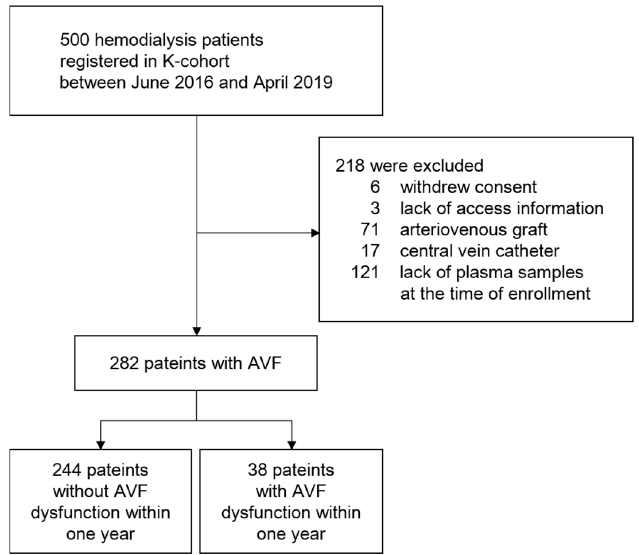
Figure 1. A flowchart of the study participant selection. Abbreviation: AVF, arteriovenous fistula.